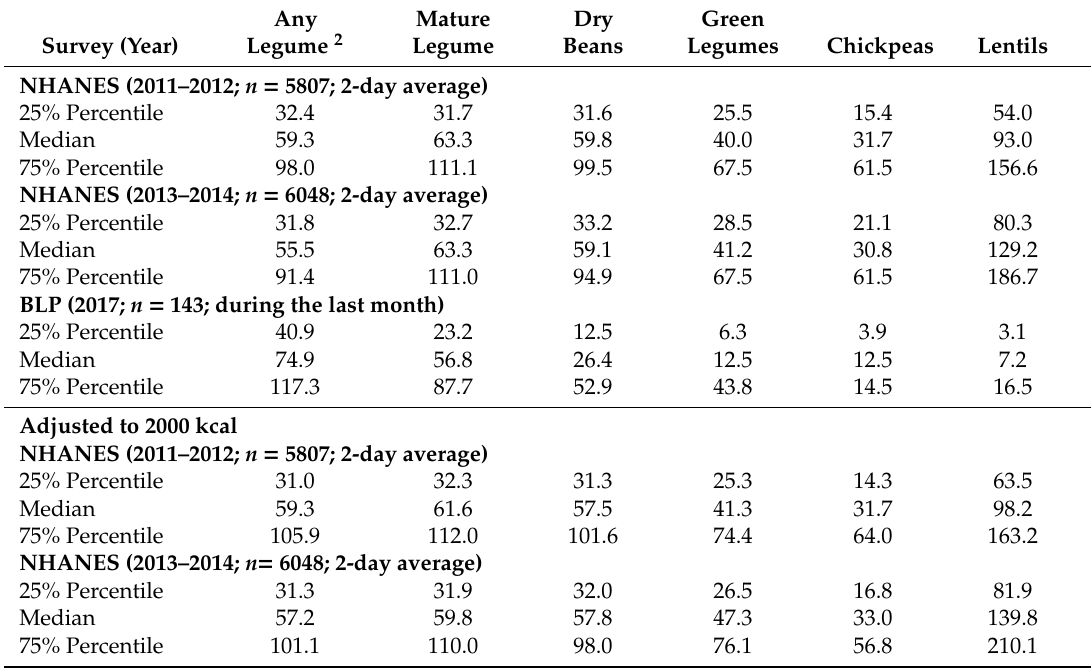
Table 4. Legume consumption levels (in g cooked legumes / day) in legume-consuming US adults: National Health and Nutrition Examination Survey (NHANES) and Beans, Lentils, Peas Nutrition Education Online Parent Survey (BLP) 1